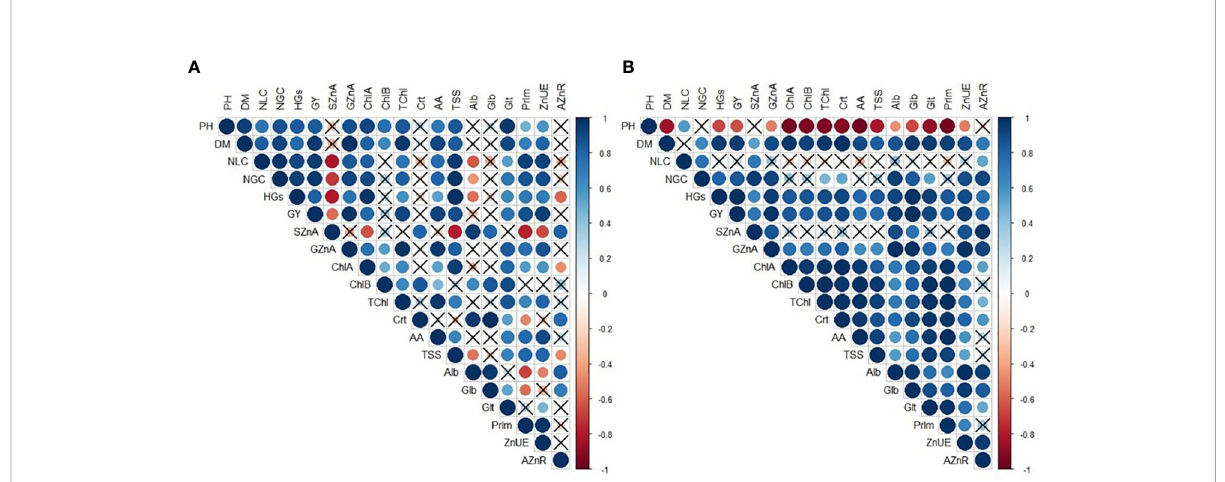
FIGURE 7 Heatmap color scale indicating Pearson ’ s correlation among evaluated attributes of maize in response to plant growth-promoting bacteria and foliar nano-zinc oxide applications in the 2019 – 20 (A) and 2020 – 1 (B) cropping seasons. "×" indicates a non-signi fi cant relationship ( p ≤ 0.05). PH, plant height; DM, shoot dry matter; NLC, number of row per cob; NGC, number of grains per cob; HGs, 100-grains weight; GY, grain yield; SZnA, shoot Zn accumulation; GZnA, grain Zn accumulation; ChlA, chlorophyll a; ChlB, chlorophyll b; TChl , total chlorophyll; Crt, carotenoids; AA, free amino acids; TSS, total soluble sugar; Alb, albumin; Glb, globulin; Glt, glutelin; Prlm , prolamin; ZnUE, Zn use ef fi ciency; and AZnR, applied Zn